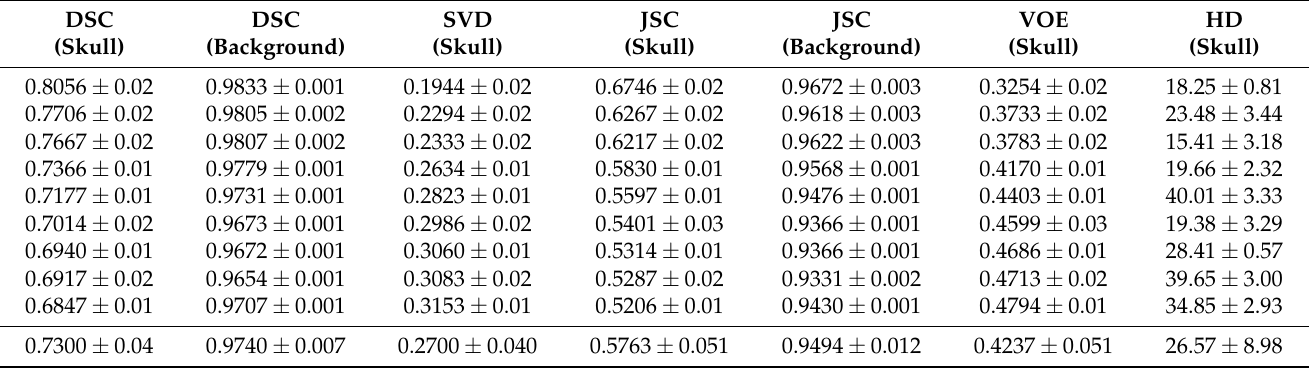
Table 2. Statistical Analysis of the first dataset.